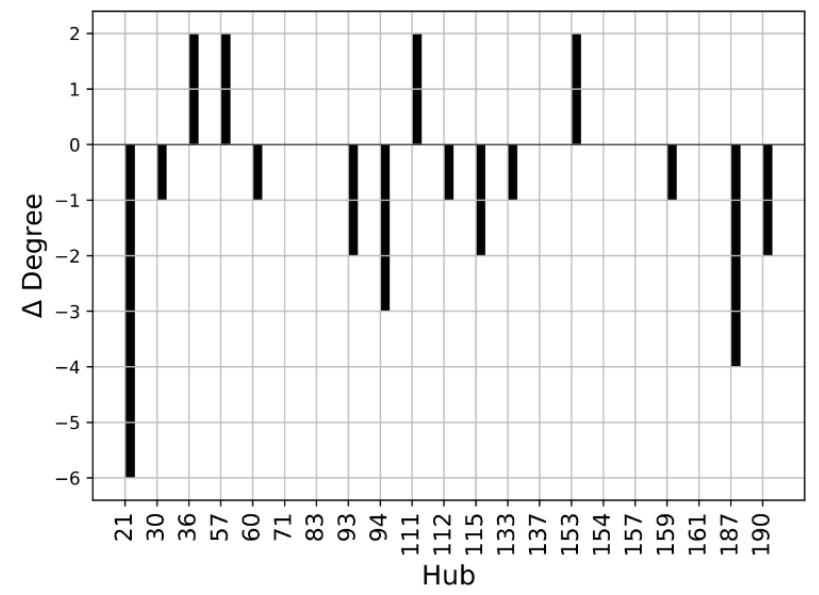
Figure 8. Hub degree comparison of WT structures: Degree ( k open − k closed ) of residues with a connectivity degree higher than 4 ( k > 4) in at least one of the two proteins. Residues are enumerated according to the PDB notation.